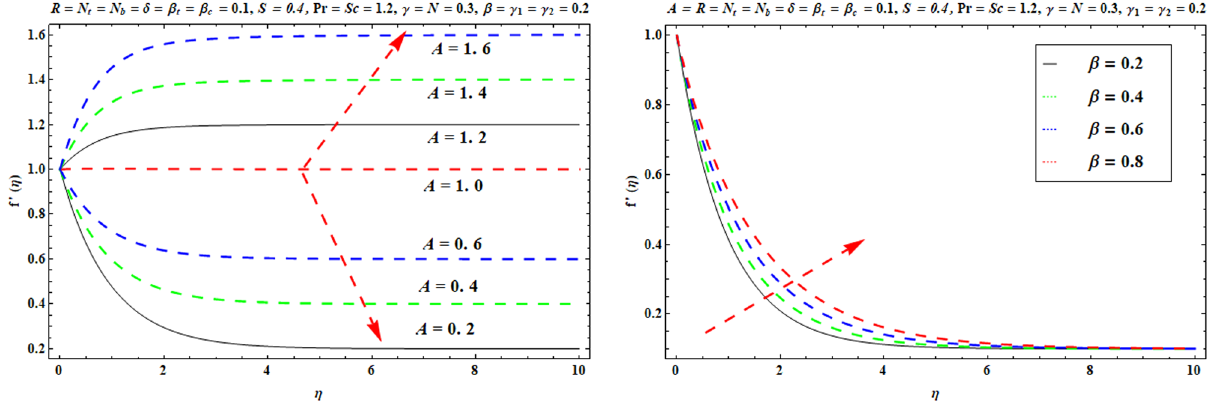
Figure 5: f η ′ ( ) versus A . Figure 6: f η ′ ( ) versus β